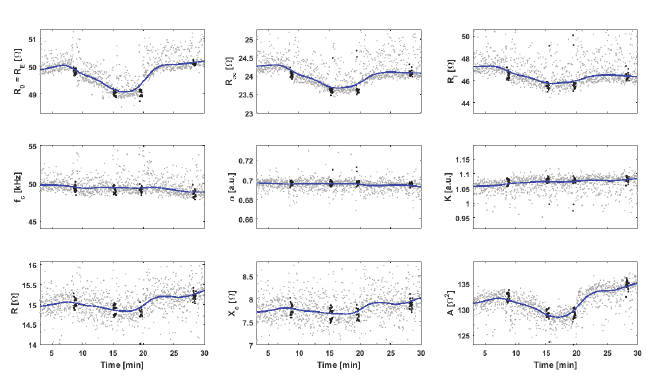
Figure 7. Evolution of BIS measures throughout the leg compression protocol in one subject. Gray dots are values obtained during periods of free breathing, black dots are values corresponding to periods of end-expiratory breath hold before, during and after leg compression, blue lines are local regression curves fitted to the data. (R 0 : resistance at low frequencies; R ∞ : resistance at high frequencies; R I : resistance intracellular fluids; f c : characteristic frequency of the tissue; α: distribution of relaxation times; K: ratio between resistance of extra- and intra-cellular fluids; R: radius of impedance arc; X c : depression of the center of impedance arc; A: impedance arc segment area. BIS = bioimpedance